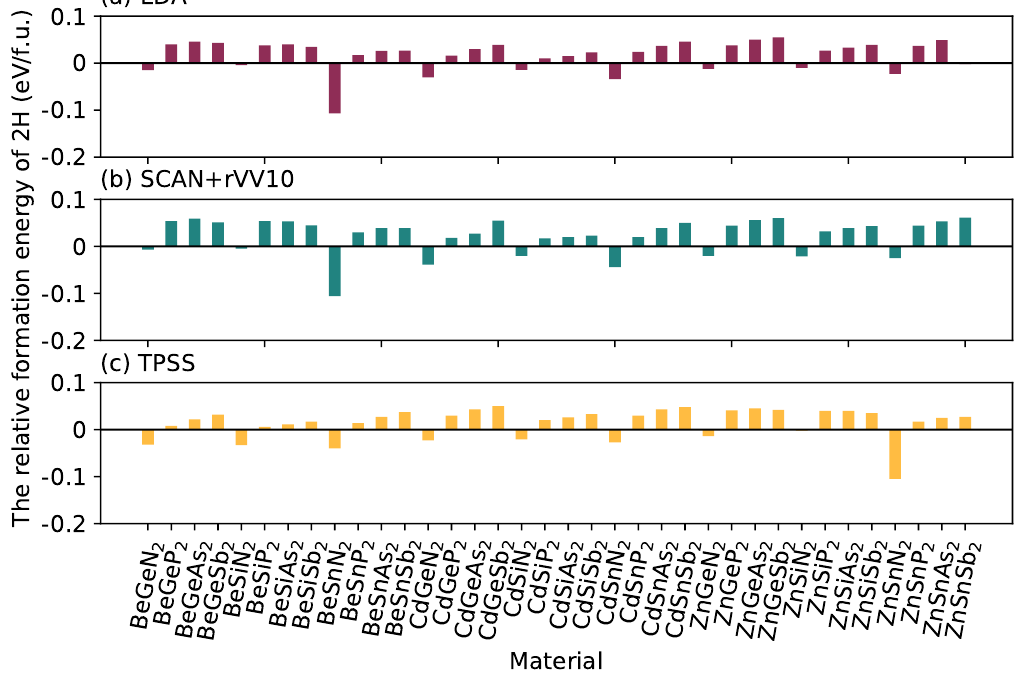
Figure 2. ( a – c ) The relative formation energy of material calculated by using LDA, SCAN+rVV10, and TPSS. The positive value means that the 3C polymorph has lower formation energy than the 2H